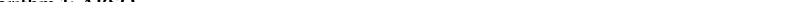
Algorithm 1: ABSO 01: for all Randomly generate a population with N individuals and calculate the fitness of each individual.